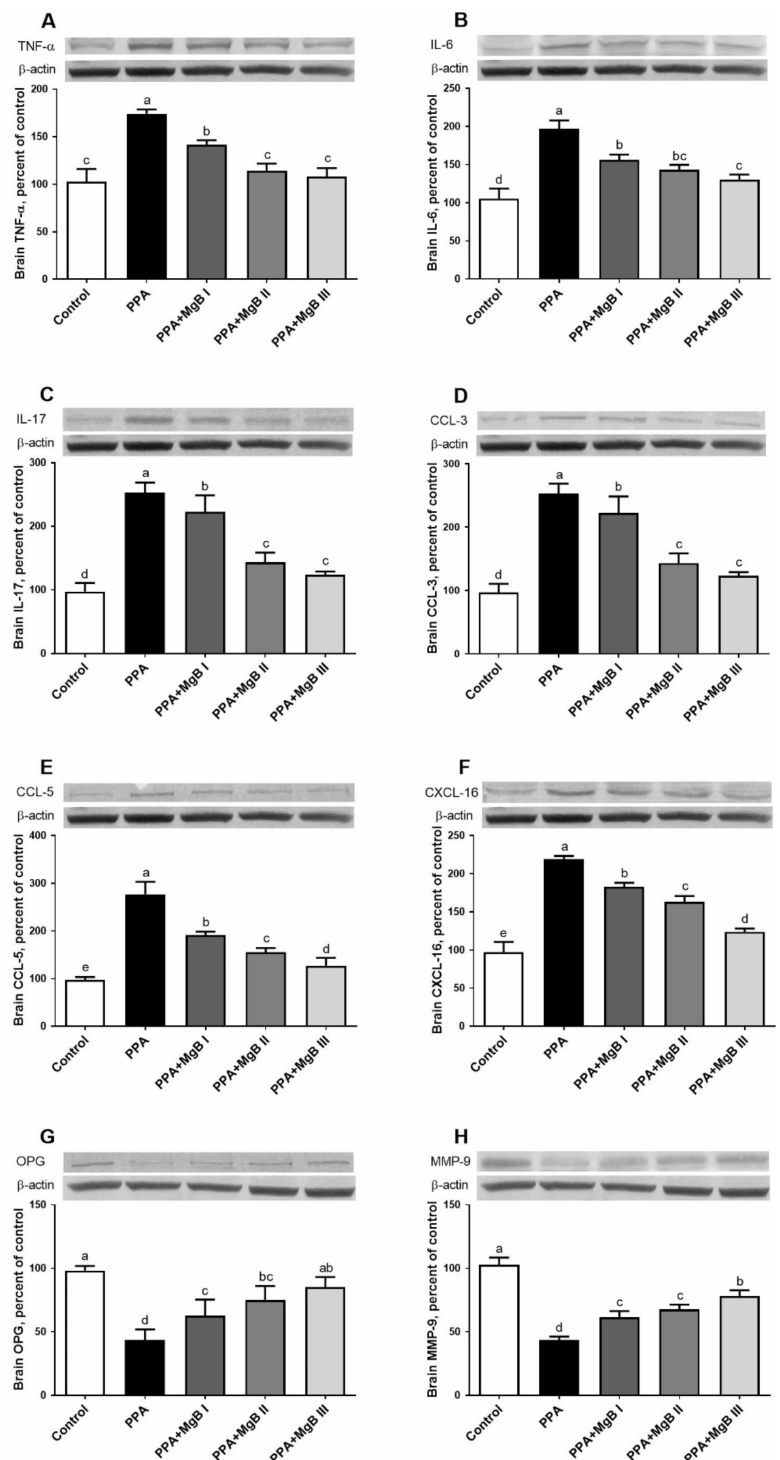
Figure 3. Effects of MgB supplementation on brain tumor necrosis factor-alpha (TNF- α , ( A )), in- terleukin 6 (IL-6, ( B )), interleukin 17 (IL-17, ( C )), chemokine (C-C motif) ligand 3 (CCL-3, ( D )), chemokine (C-C motif) ligand 5 (CCL-5, ( E )), chemokine (C-X-C motif) ligand 16 (CXCL-16, ( F )), brain osteoprotegerin (OPG, ( G )) and matrix metallopeptidase 9 (MMP-9, ( H )) protein levels in PPA-induced autism in rats. Data are shown as a percent of the control value. Blots were repeated at least three times. a–e: Values within the bars with different superscripts are significantly different (Tukey’s post-hoc test, p <